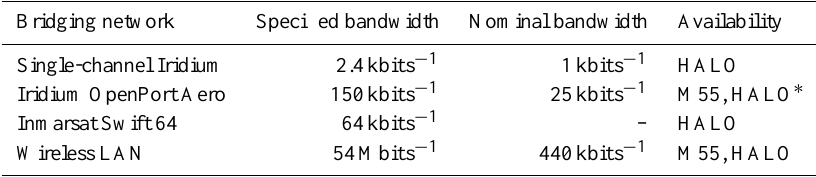
Table 1. Available networks for the connection between the central control computer on the aircraft and the Laboratory-LAN. No nominal bandwidth is given for the Inmarsat system as it has not been used to date. The nominal bandwidth is the bandwidth typically used for issuing commands and for the housekeeping feed. Extraordinary activities such as running a remote desktop connection between the ground and the central control computer are not included in this nominal bandwidth.